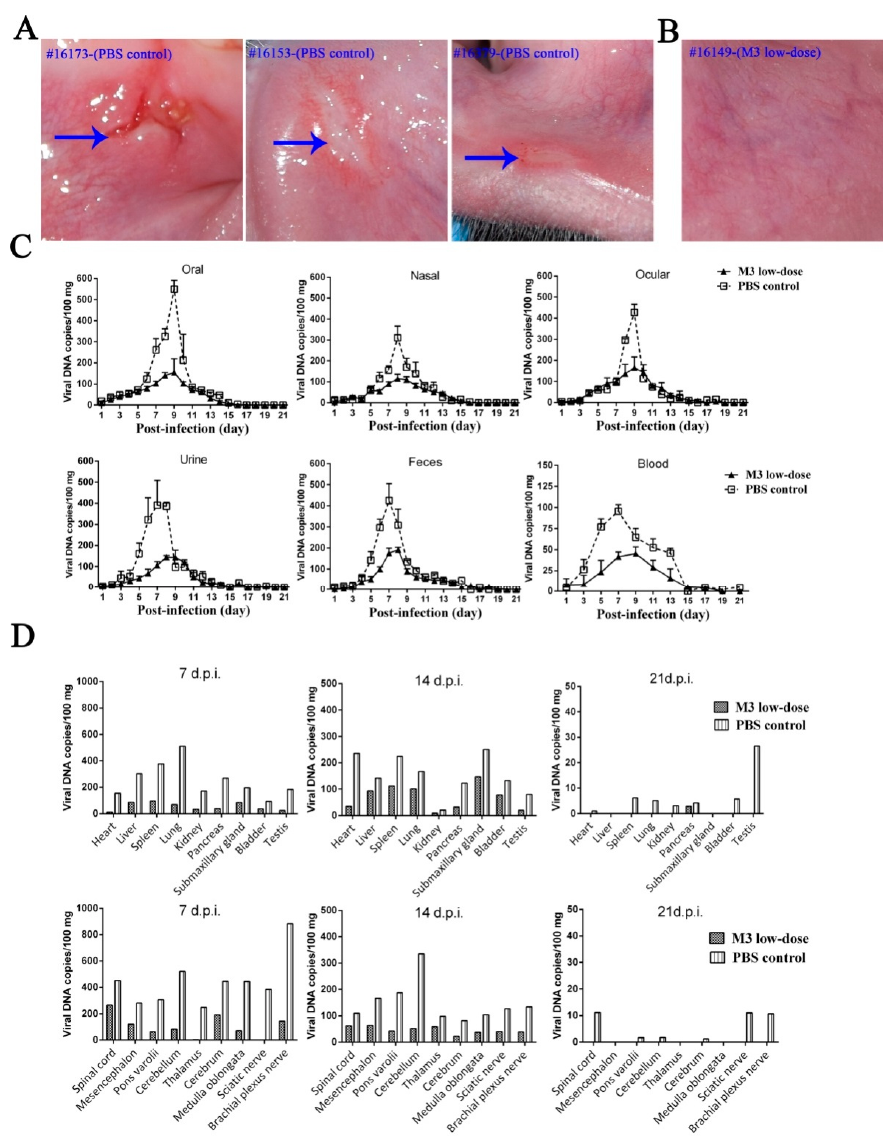
Figure 5. The immune-protective effect observed in M3 low-dose-immunized macaques challenged with the 17 + strain. ( A ) Vesicles in the oral mucosa of control macaques (#16173, #16153, and #16379, exhibited on day 5, 8, and 7, post-infection, respectively) are indicated by arrows. ( B ) All the M3 low-dose-immunized macaques were asymptomatic (#16149 was selected as a representative). ( C ) Detection of virus shedding in feces and urine samples and in oral, nasal, and ocular swabs collected for 21 days after the infection. Blood samples were collected every two days for 21 days after the infection. ( D ) Detection of the viral loads in various organs from macaques belonging to the PBS control and M3 low-dose groups collected on days 7, 14, and 21, post-infection.